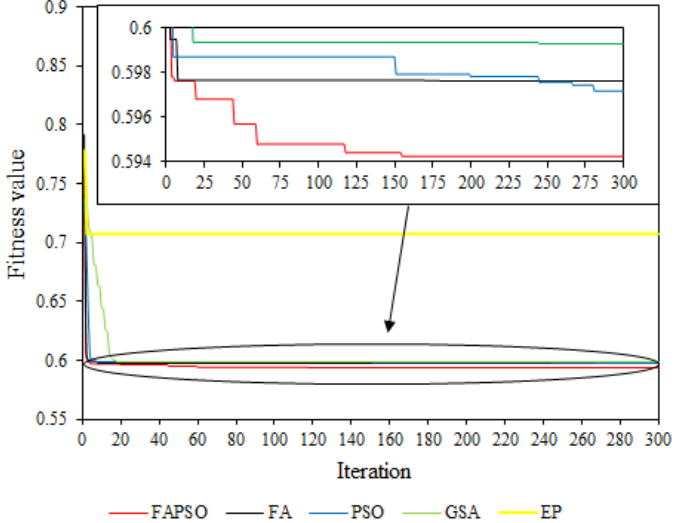
Figure 9. Convergence characteristic for FAPSO, FA PSO, GSA and EP optimizations at time 15:00.